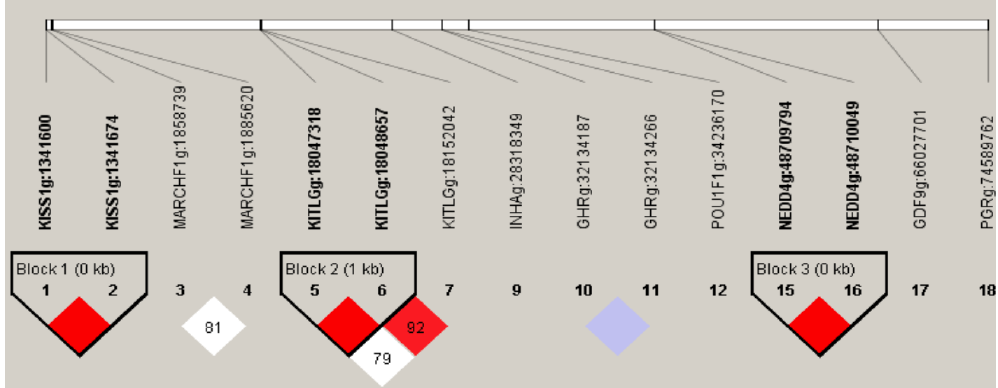
Figure 3. Linkage disequilibrium plot of 15 significant association loci. Intra-gene haplotypes (with blocks) are illustrated based on r 2 measurements. The numbers in blocks represent r 2 values. The degree of LD is reflected by the color intensity of the block. Red boxes are tag mutations included in association analysis. Linkage disequilibrium pattern for the significant SNPs in KISS-1 , KITLG and NEDD4 gene. Scale of red color indicates the extend linkage disequilibrium ( D (cid:48) value).